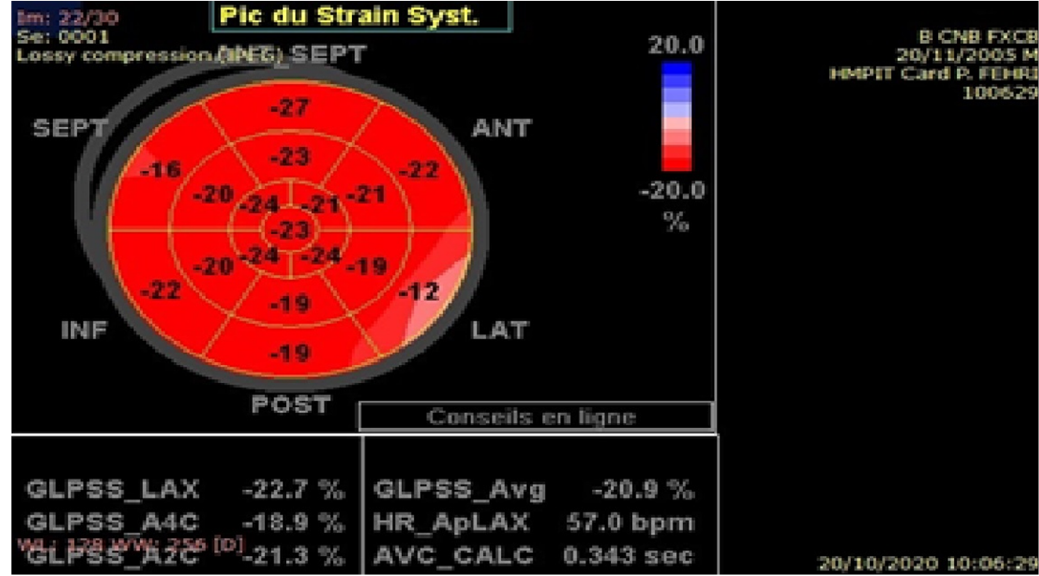
Figure 2. Segmental and global left ventricular longitudinal strain in a healthy